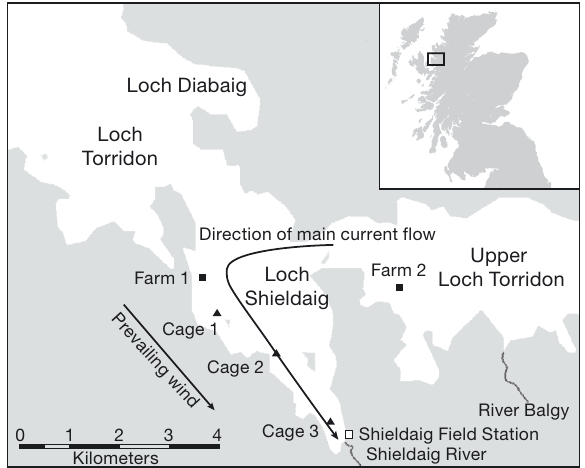
Fig. 1. Loch Shieldaig study site, with sentinel cage (Cages 1, 2 and 3) locations, prevailing wind, main current from Up- per Loch Torridon under prevailing wind conditions, main local rivers, Marine Scotland-Science (MSS) Shieldaig Field Station, and marine aquaculture sites (Farms 1 and 2) marked. Inset: location of study site in Scotland,